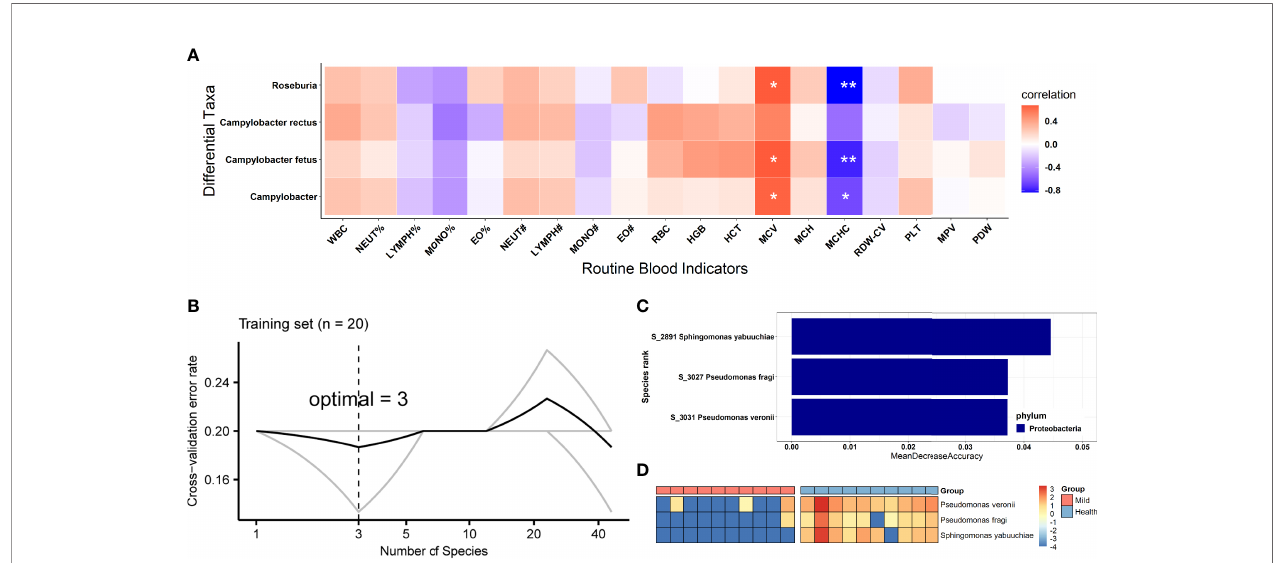
FIGURE 4 | Biological relevance between the differential oral bacteria and clinical RBI and the identi fi cation of biomarkers based on oral microbiota for SARS-CoV-2 patient diagnosis. (A) Heatmap of Spearman ’ s rank correlation coef fi cients between differential oral bacteria based on viral load and clinical blood parameters. Statistically signi fi cant associations are shown with asterisks, as follows: *p < 0.05, **p < 0.01. (B) The top 3 biomarker bacterial species were identi fi ed by applying a random forest classi fi er of their relative abundances. (C) Biomarker taxa are ranked in descending order of importance to the accuracy of the model. (D) Heatmap showing the relative abundances of the top 3 disease-predictive biomarker bacterial taxa. WBC, white blood cells; NEUT%, neutrophilic granulocyte percentage; LYMPH%, lymphocyte percentage; MONO%, monocyte percentage; EO%, eosinophil percentage; NEUT#, absolute neutrophil count; LYMPH#, absolute lymphocyte count; MONO#, absolute monocyte count; EO#, absolute eosinophil count; RBC, red blood cells; HGB, hemoglobin; HCT, hematocrit; MCV, mean corpuscular volume; MCH, mean corpuscular hemoglobin; MCHC, mean corpuscular hemoglobin concentration; RDW-CV, red cell distribution width; PLT, platelet count; MPV, mean platelet volume; PDW, platelet distribution width; RBI, routine blood